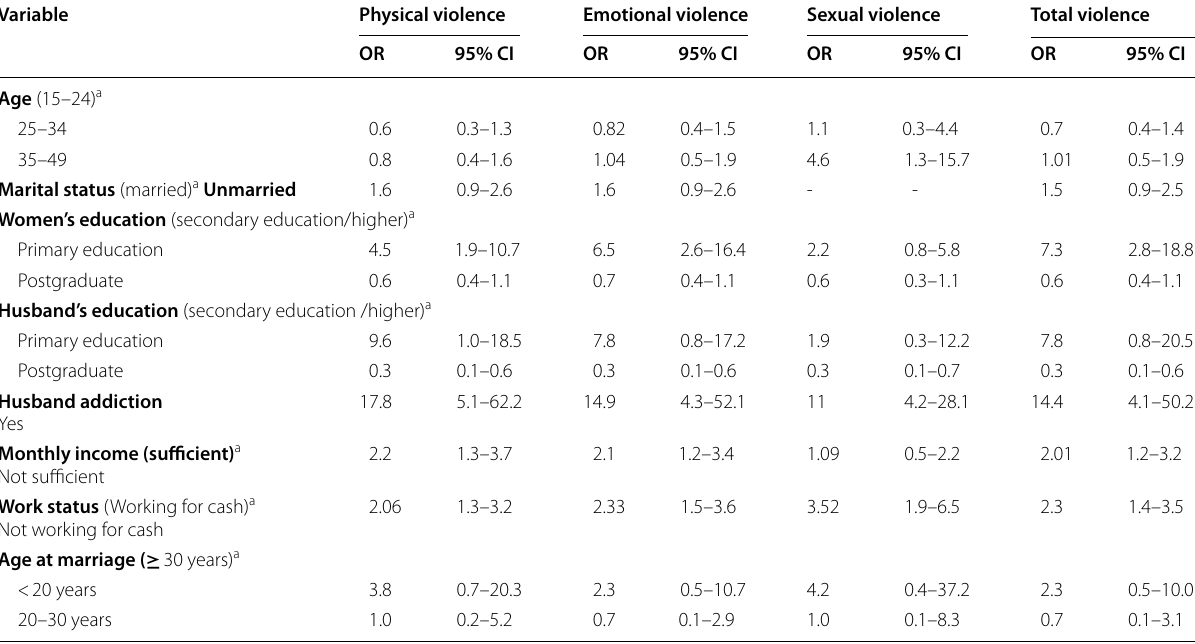
Table 5 Binary logistic regression analysis of factors associated with each type of domestic